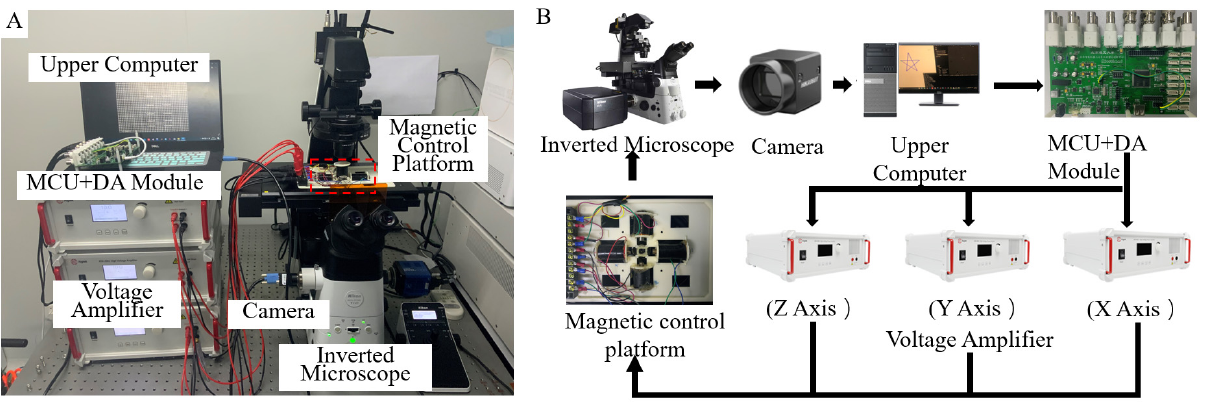
Figure 4. System setup. ( A ) Experimental system of a magnetic microrobot with computer vision. ( B ) System workflow.